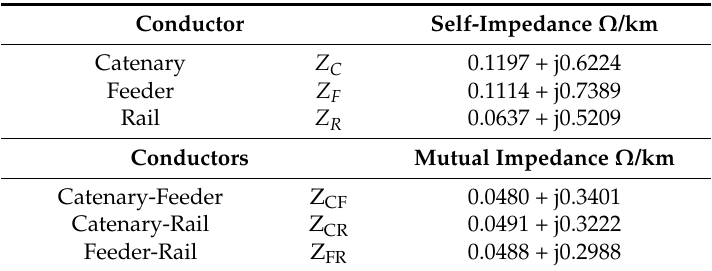
Table 1. Self and mutual impedance values of railway conductors.